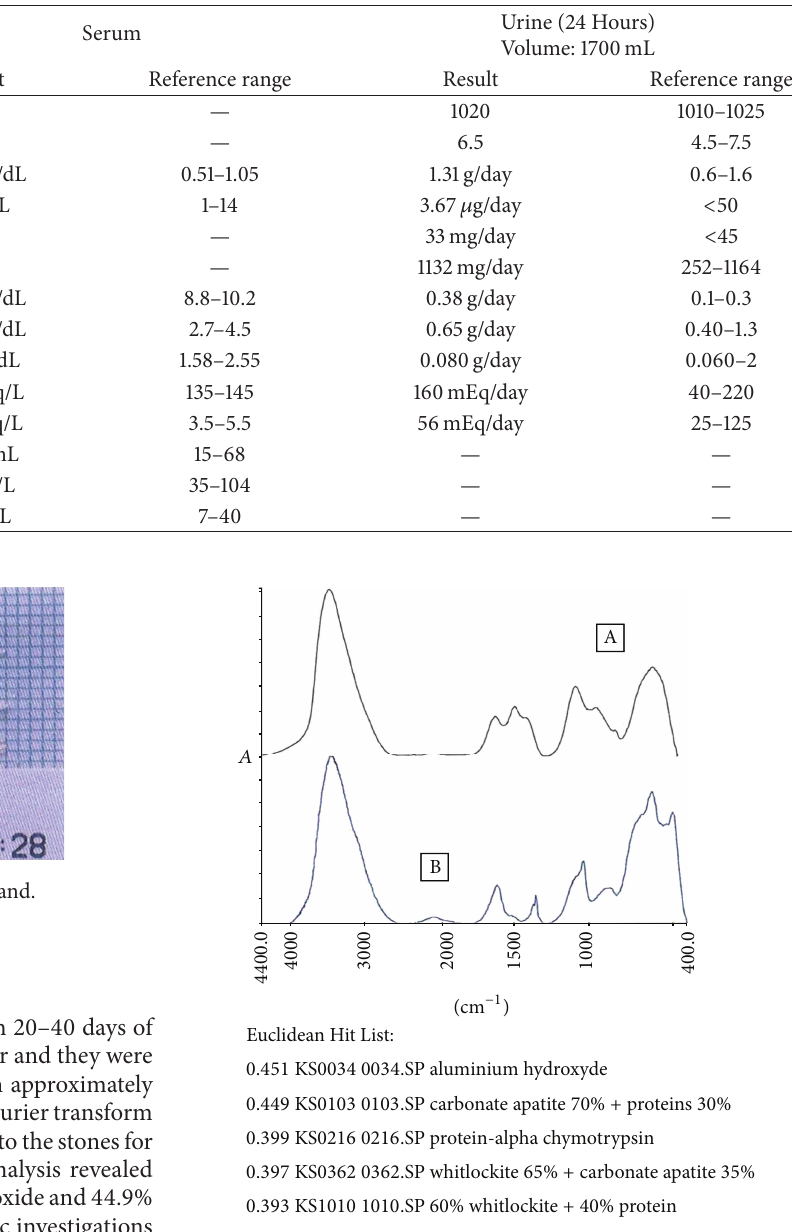
Figure 2: The analysis of stones (Fourier transform infrared spec-